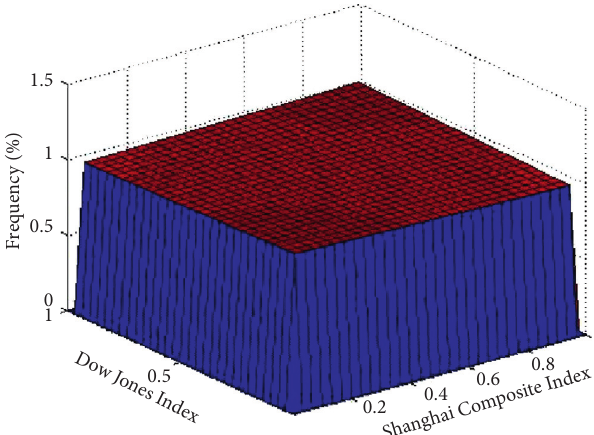
Figure 4: Normal Copula distribution of SSE index and Dow Jones Index extreme volatility series based on B segment weekly data.